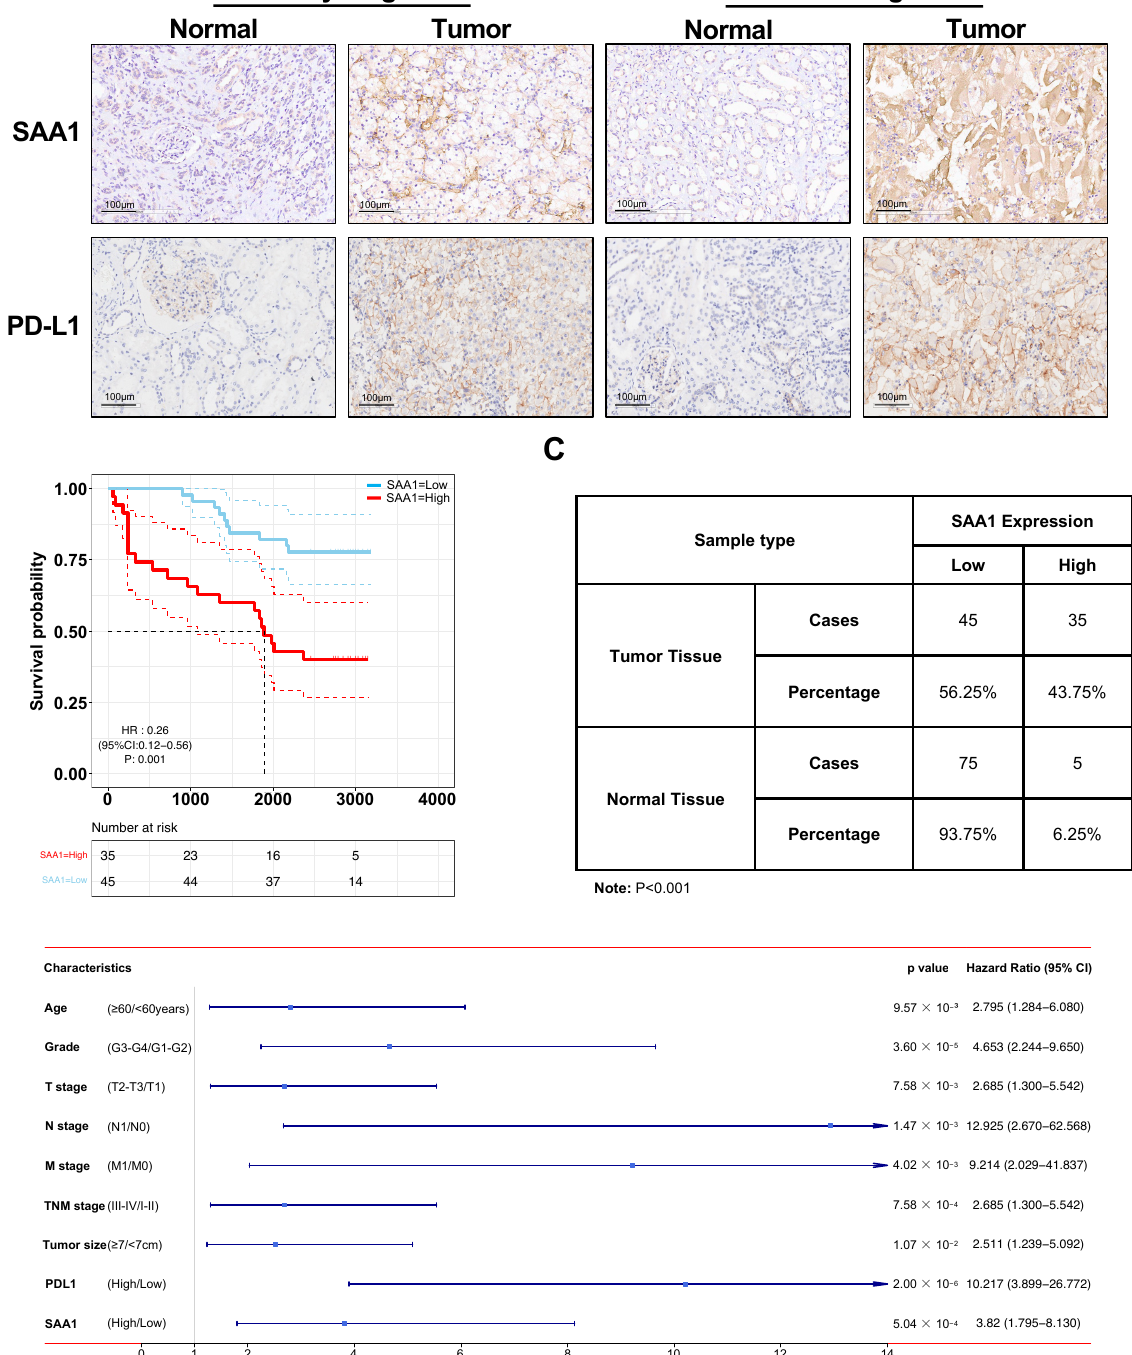
Figure 7. Validation of SAA1 in ccRCC in external independent cohort. ( A ) Immunohistochemistry staining of SAA1 in early stage and late stage ccRCC. ( B ) OS rates stratified by low SAA1 expression and high SAA1 expression from the TCGA database. The median was used as the dividing line for high or low SAA1 expression. ccRCC patients with high expression of SAA1 had a worse OS rate than those with low expression of SAA1. ( C ) SAA1 expression in ccRCC tissues and adjacent normal tissues ( n = 80). ( D ) Cox regression analyses of each clinical feature, PD-L1, SAA1, and patient survival in our clinical validation